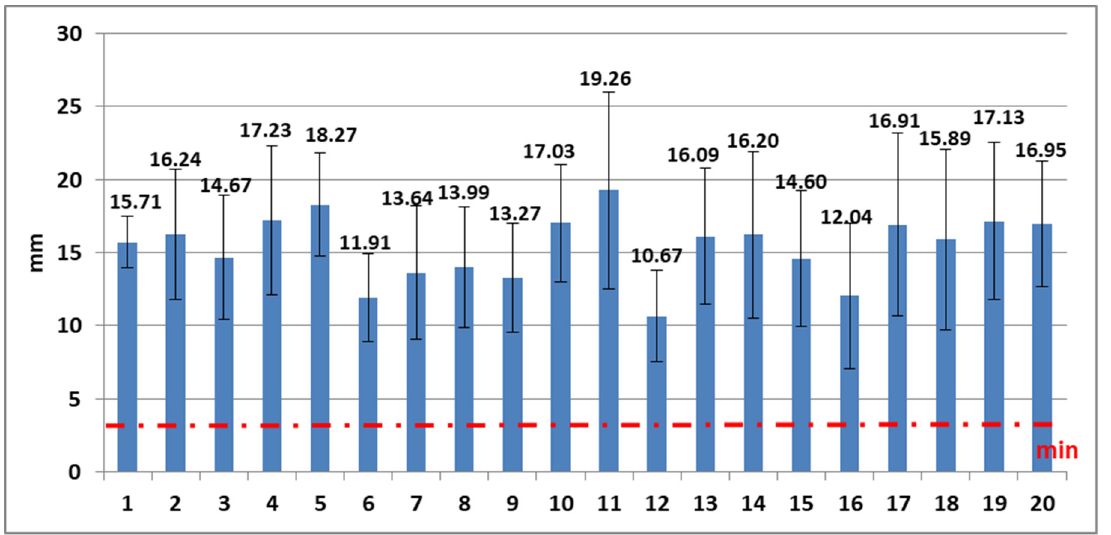
Figure 12. Mean length values (mm) of the pellets.